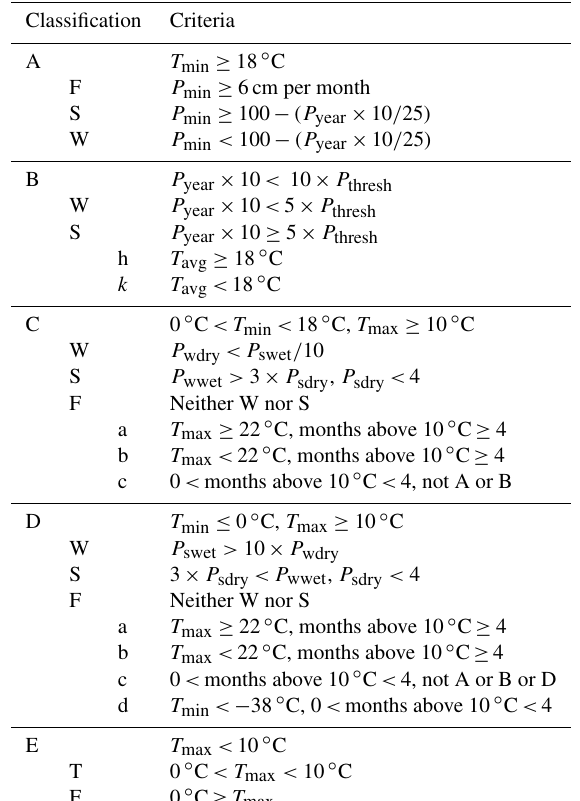
Table 1. Classification criteria for the Köppen–Geiger classifica- tion scheme. T min is the average temperature of the month with the lowest average temperature. T max is the average temperature of the month with the highest average temperature. P min is the av- erage precipitation of the driest month. P max is the average pre- cipitation of the wettest month. T avg is the mean annual temper- ature. P year is the mean annual precipitation. P thresh varies ac- cording to the following rules (if 70% of P year occurs in winter then P thresh = 2 × T avg , if 70% of P year occurs in summer then is the precipitation of the driest month in summer, P wdry is the pre- cipitation of the driest month in winter, P swet is the precipitation of the wettest month in summer, and P wwet is the precipitation of the wettest month in winter. In the Northern Hemisphere, summer is defined as AMJJAS and winter as ONDJFM; the opposite is true for the Southern Hemisphere. Due to overlapping criteria, dry (B) climates are prioritized above all others (temperature is given in ◦ C, and precipitation is given in centimetres per month and cmyr − 1 ).